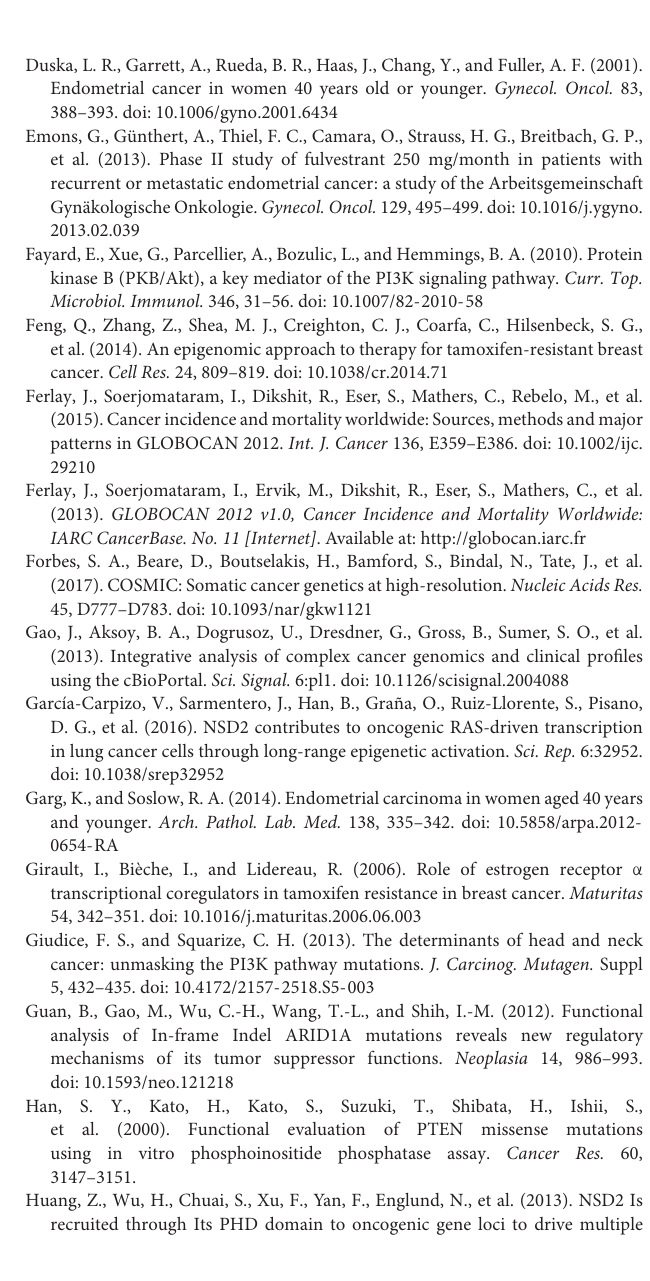
TABLE S5 | Somatic alteration identified as driver mutations by Cancer Genome Interpreter. TABLE S8 | Somatic alterations of ER positive subtype in genes relevant to estrogen signaling pathway. TABLE S9 | Somatic alterations of ER negative subtype in genes relevant to estrogen signaling pathway. TABLE S10 | Recurrent mutation site of WHSC1 in different